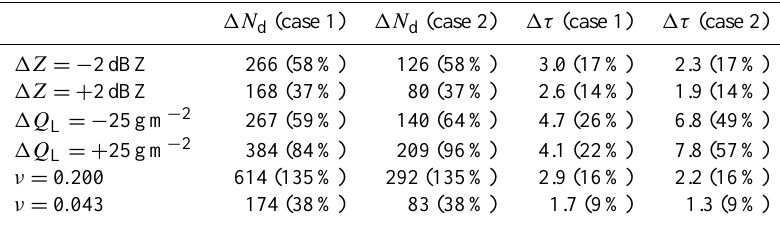
Table 3. Uncertainty estimation for N d and τ by varying Z , Q L and the effective variance of the gamma distribution ν . Relative uncertain- ties are given in brackets. Case 1: 21 April 2013, 11:00UTC. Q L = 69gm − 2 , H = 311m, f ad = 0 . 76. Retrieved values: N d = 456cm − 3 applying ν = 0 . 1, τ = 18. Case 2: 1 June 2012, 13:30UTC. Q L = 62gm − 2 , H = 342m, f ad = 0 . 55, N d = 216cm − 3 , τ = 13 . 6.